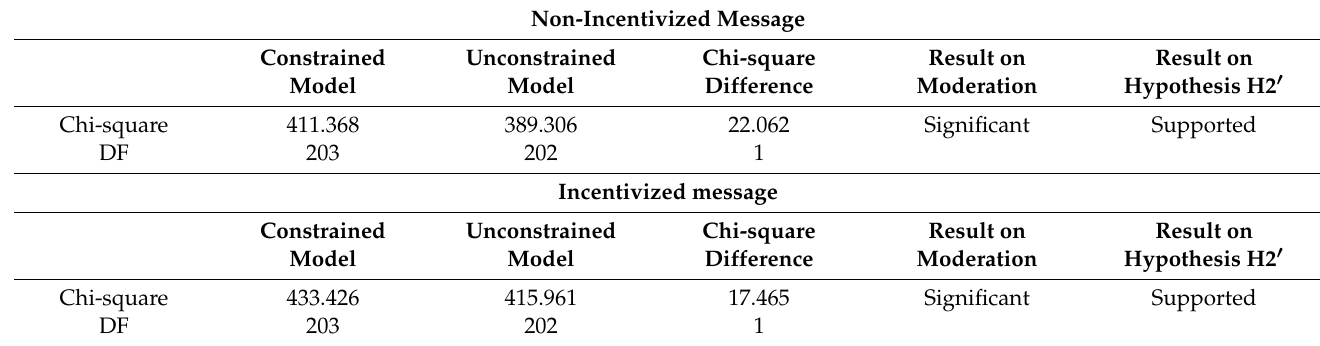
Table 7. Moderation test of the message type in the relationship between perceived source expertise and message